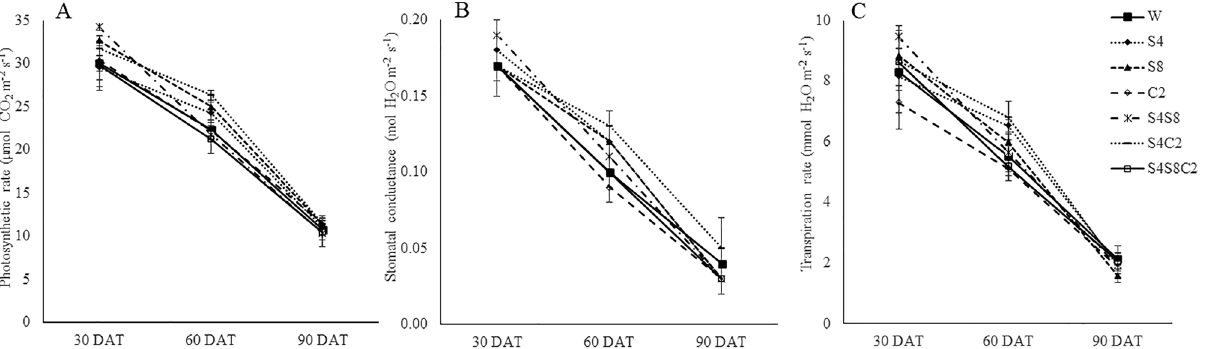
Figure 4. Effect of bacterial inoculation on photosynthesis parameters including photosynthetic rate ( A ), stomatal conductance ( B ), and transpiration rate ( C ). W: uninoculated plant as control, S4: B. subtilis S42, S8 : E. cloacae S81, C2: P. azotoformans C2-114, S4S8: co-inoculation B. subtilis S42 and E. cloacae S81, S4C2: co-inoculation B. subtilis S42 and P. azotoformans C2-114, S4S8C2: mix of all strains.